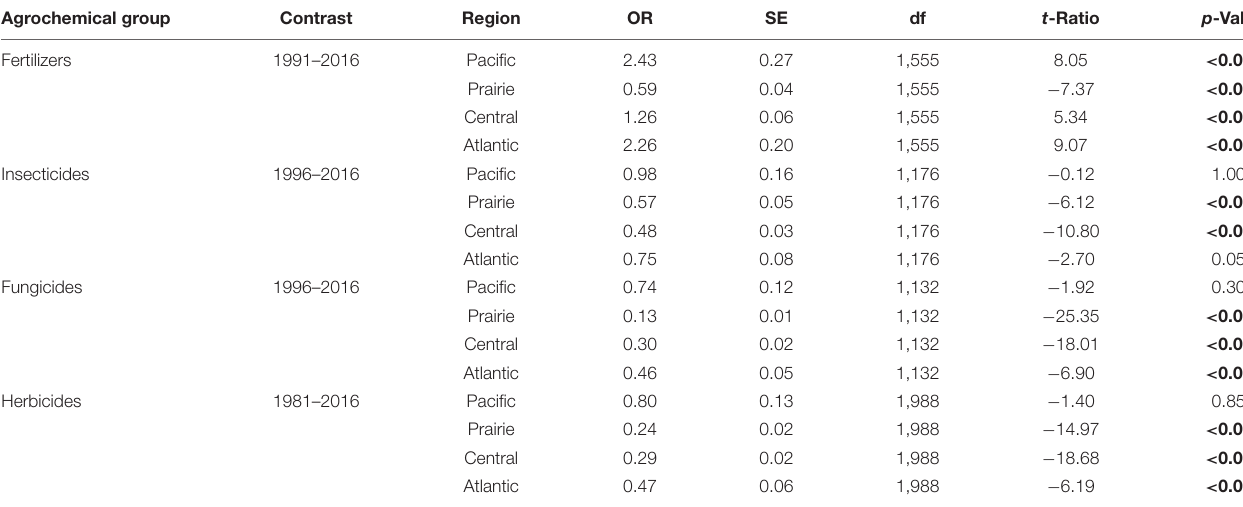
TABLE 2 | Pairwise contrasts between the earliest and latest Census of Agriculture year of area treated (estimated marginal means) with fertilizers, insecticides, fungicides and herbicides across Canada’s four agricultural regions. Agrochemical group Contrast Region OR